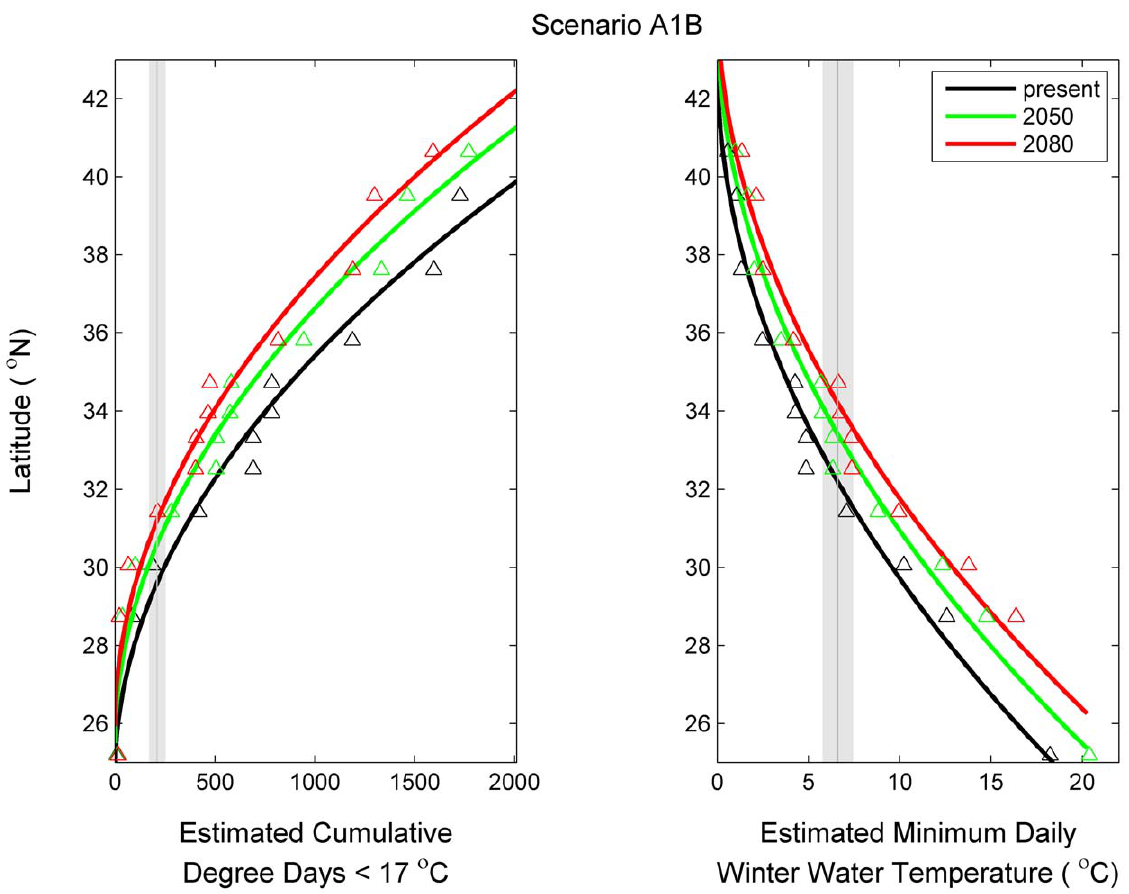
Figure 5. Estimated latitude of thermal tolerance metrics under the A1B emission scenario at three time periods. The gray line and shading represent the thermal tolerance metric and 95% confidence intervals for gray snapper juveniles as determined from an experimental study